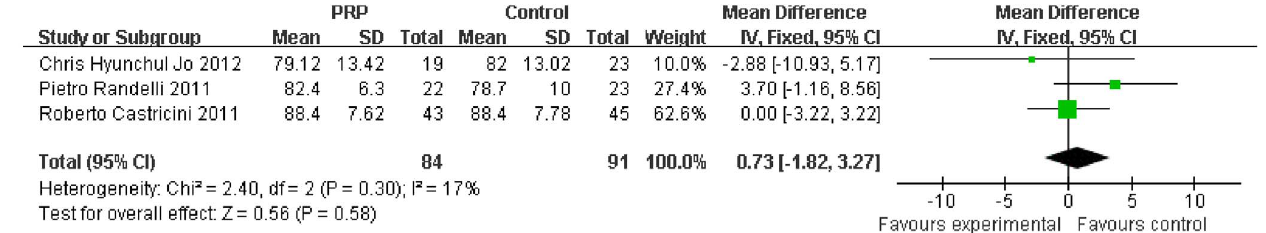
Figure 3. Difference in the Constant scale.